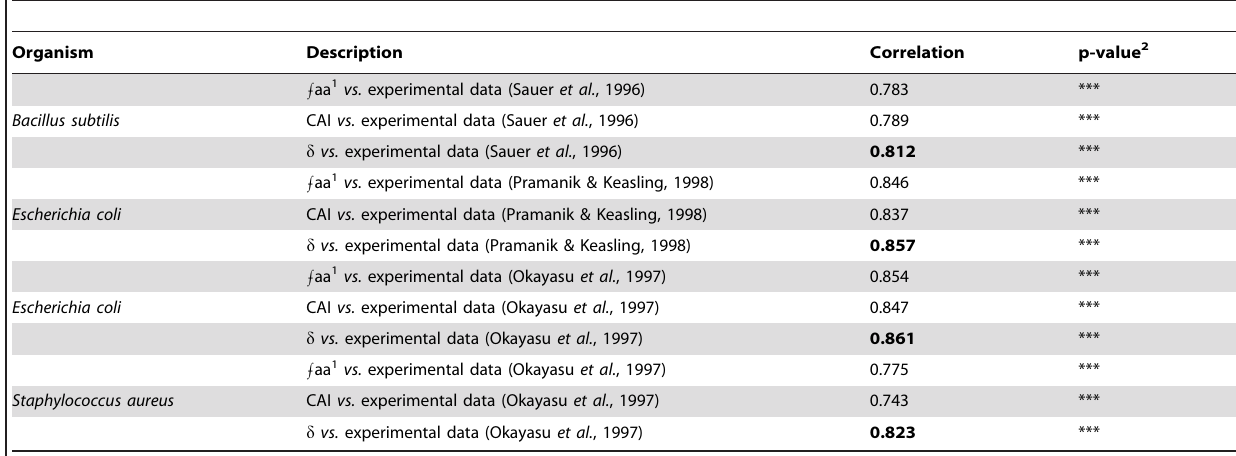
Table 2. Spearman rank correlation coefficients between estimated amino acid compositions (based on CAI and d predictors) and experimentally-determined amino acid abundances.